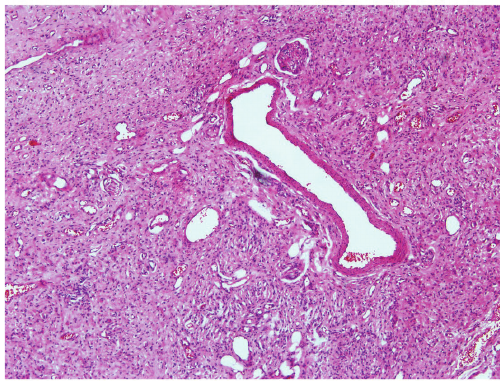
Figure 4: Peripheral nerve tissue within the perineural sheath and dilated blood capillaries.